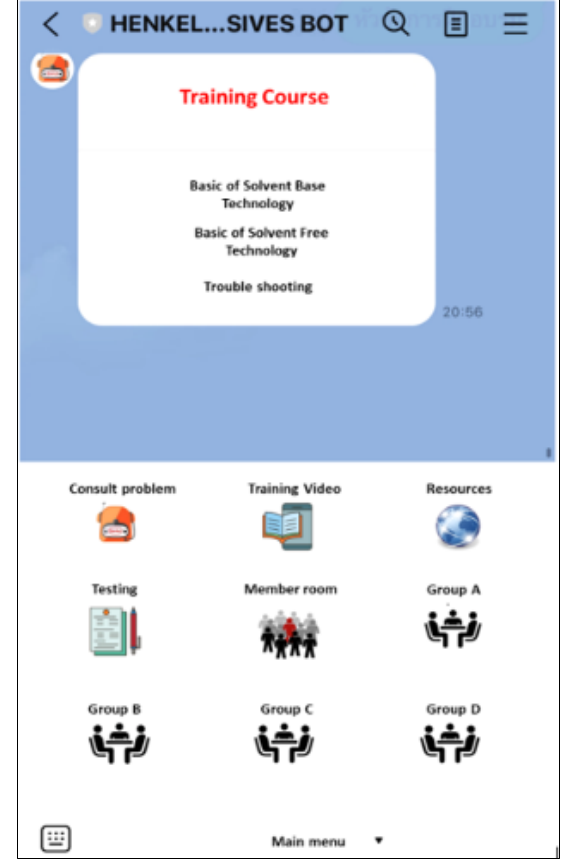
Figure 3. Main menu of chatbot LINE application on personal mobile